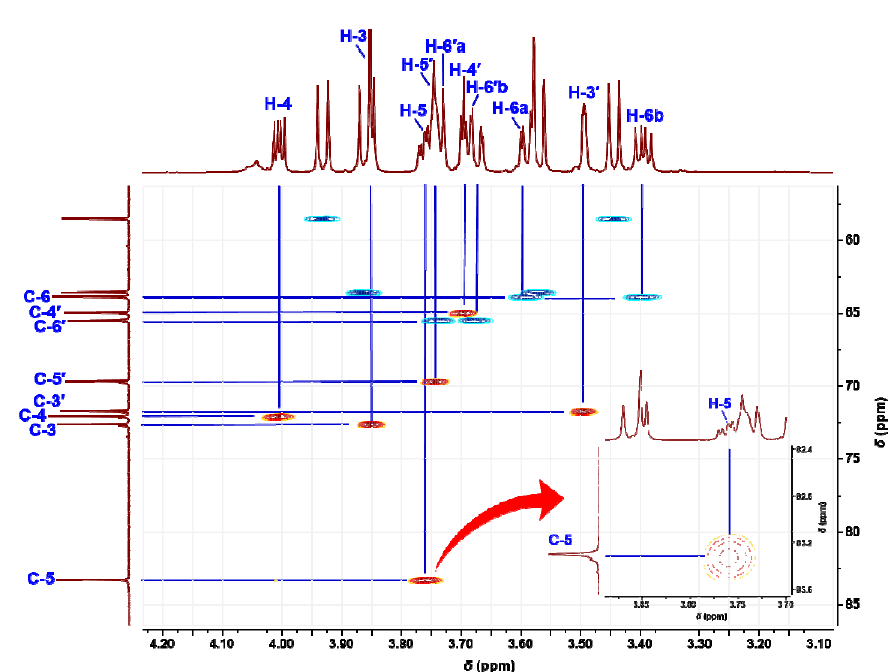
Figure 3. Heteronuclear single quantum coherence spectrum of di- D -psicose anhydride.